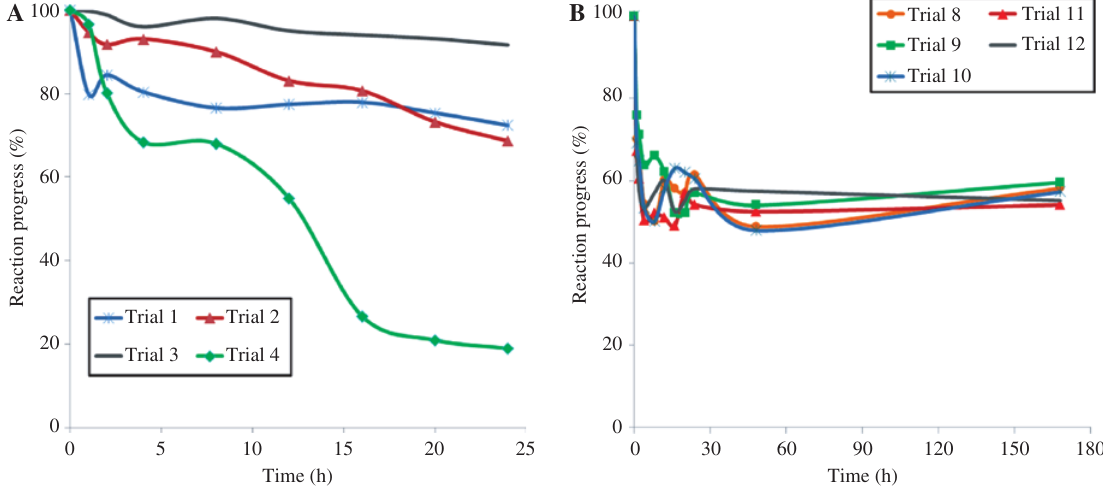
Figure 4: (A) Trials at different molar ratios and similar catalysis and heating conditions. (B) Effect of reaction time on the reaction progress.